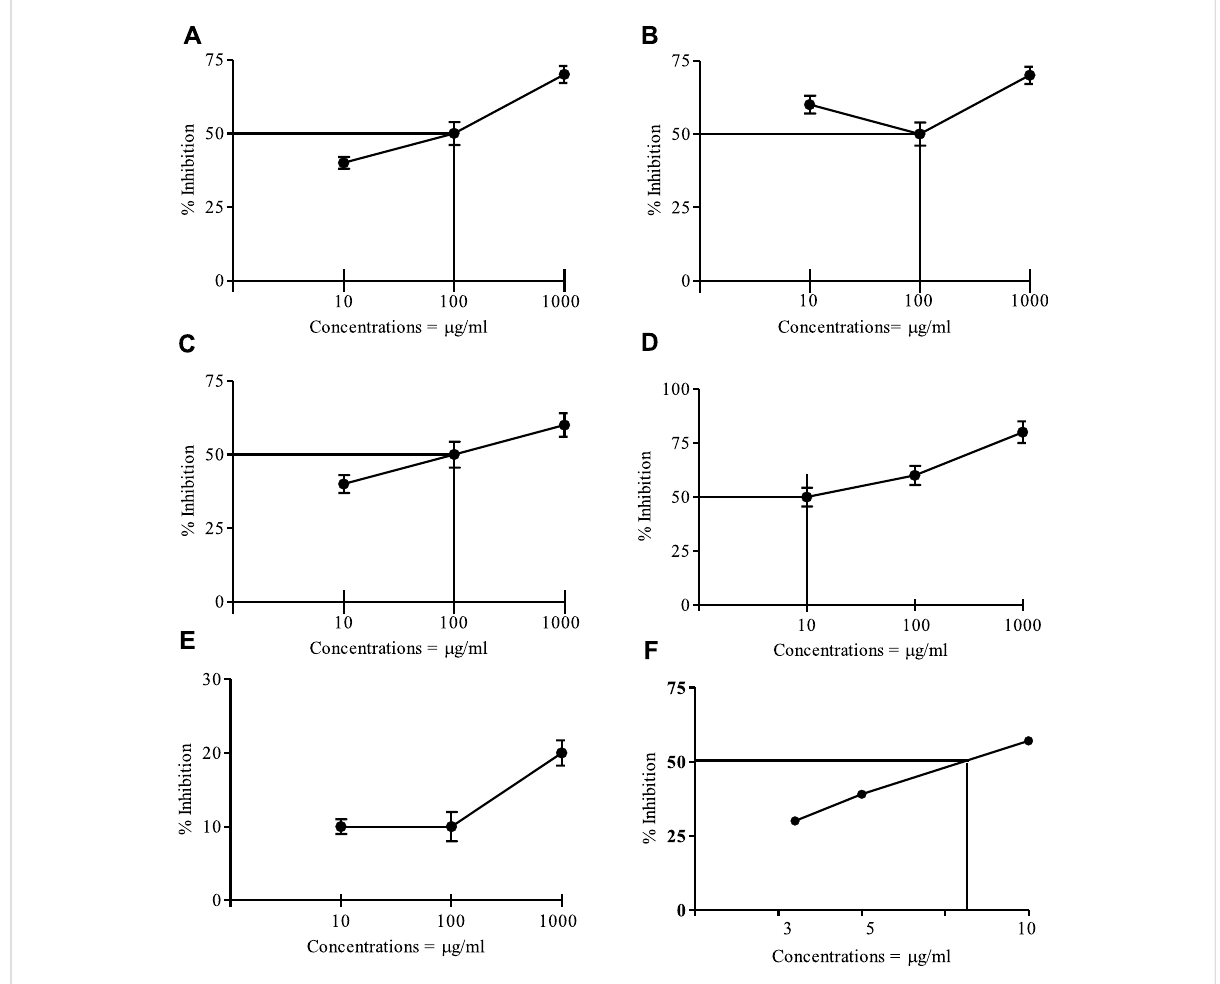
FIGURE 1 Brine shrimp cytotoxic effect of the crude and fractions of I. spicata at various Concentrations. (A) = Crude drug, (B) = Hexane fraction; (C) = Chloroform fraction; (D) = Ethylacetate fraction; (E) = Water fraction; (F) = Etoposide, IC 50 = 7.35 μ g/ml. Data are mean ±SEM ofthree independent